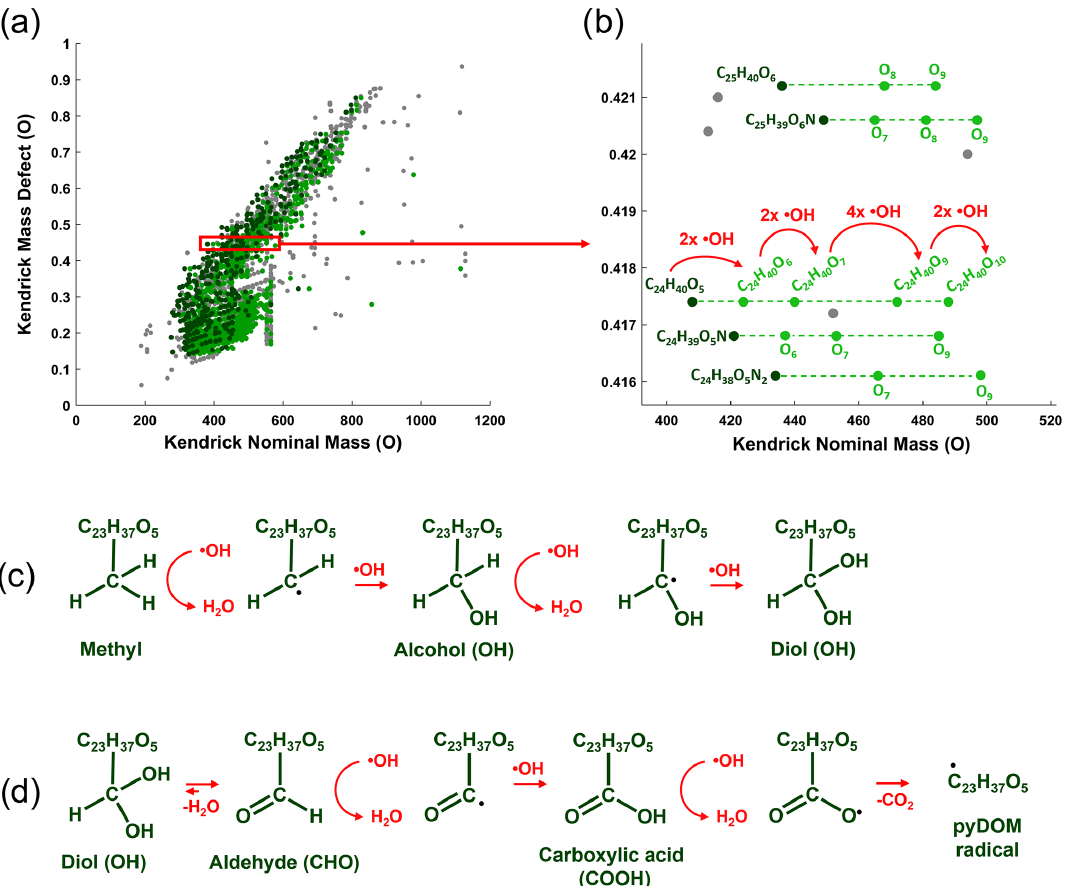
Figure 4. Kendrick mass defect (KMD) analysis using oxygen (O) series of the bio-produced formulas of Oak 400 Fresh pyDOM. Panel (a) shows the whole KMD plot, while (b) shows an expanded region of it. Formulas not part of the O KMD series are colored in gray. Formulas in dark green are proposed substrates, and their oxygenation products are colored in light green. Only the molecular formulas for one of the series (KMD = 0.4174Da) are labeled, while for the rest of the series, only the substrate formula and the number of oxygens in the oxygenation products are listed for clarity. The red arrows show the formation of the four oxygenation products of the C 24 H 40 O 5 substrate (cid:113) after a sequential attack by hydroxyl radicals ( OH). Panel (c) shows possible chemical reactions that can cause an increase in the number of oxygens. Panel (d) shows further oxidative processes involving the formation of keto and carboxyl groups, processes which ultimately produce pyDOM radicals and CO 2 . The KMD plots for all samples are shown in Figs.